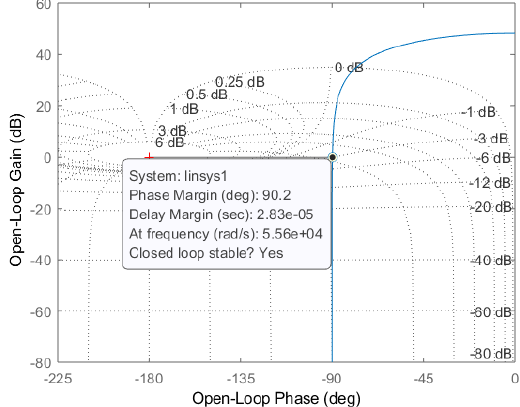
Figure 10. Location cabinet with hardware installed, for testing at Great Central Railway Quorn and Woodhouse Station, UK.